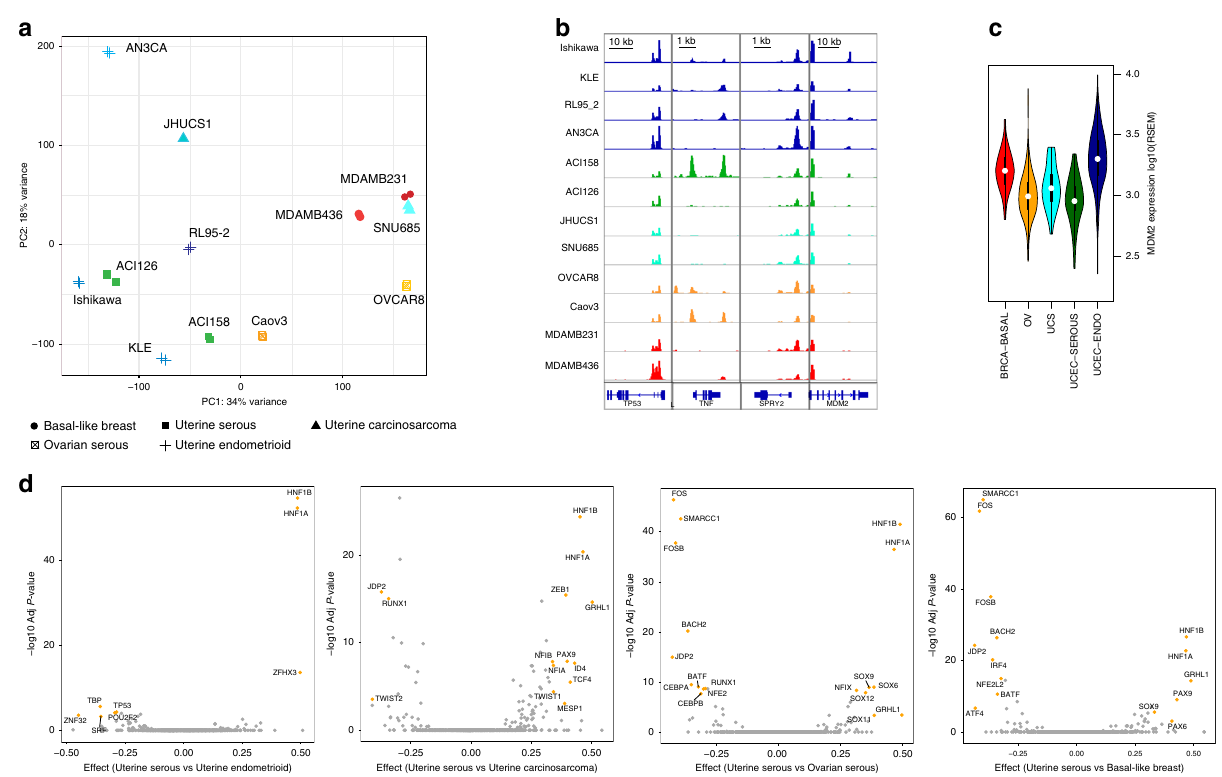
Fig. 2 ATAC-seq analysis identi fi es key TFs in gynecologic and basal breast cancer cells. a Unsupervised principal component analysis based on the chromatin accessibility for all 12 cell lines at each of the 10K most variable chromatin accessible regions in the cell line panel. Samples are color coded according to the cell line type. Each symbol represents a single biological replicate and different symbols represent the tumor type of origin. Source data are provided as a Source Data fi le. b Normalized ATAC-seq pro fi les at important genes. Pro fi les represent the union of all biological replicates for each cell type. Genomic coordinates for the loci: TP53 , chr17:7571720 – 7590868; TNF , chr6:31543344 – 31546112; SPRY2 , chr13:80910112 – 80915086; MDM2 , chr12:69201952 – 69239324. All y -axis scales range from 0 to 235 in normalized arbitrary units. The x -axis scale is indicated by the scale bars. c Violin plots indicate the distribution of MDM2 gene expression across tumor types. MDM2 gene expression is higher in uterine endometrioid carcinomas (UCEC- ENDO) compared to other tumor types. d Pairwise comparison of transcription factor motifs enriched in differentially accessible regions in cell lines. Volcano plot showing effect size versus – log10(adjusted P ), using a Bonferroni correction to adjust P values for each plot. TF symbol annotations are written where the absolute value of the effect size is in at least top 30 and adjusted P < 10 − 3 . The foreground occurrence is the number of peaks containing a particular TF motif within the group of 5000 upregulated or 5000 downregulated peaks according to log 2 -fold-change read counts, respectively. The background occurrence is the number of peaks containing a particular TF motif found among all the differentially accessible peaks. Remaining pairwise comparisons are shown in Supplementary Fig. 3. Source data are provided as a Source Data fi